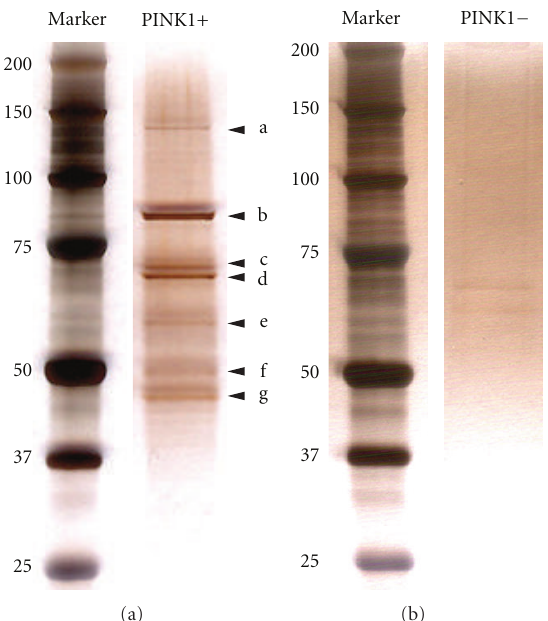
Figure 1: SDS-PAGE result after TAP with overexpressed PINK1. (a) A TAP approach was performed with HEK cells overexpressing PINK1 (PINK1+). Purified proteins were resolved by SDS-PAGE and visualized on the gel by silver staining. Protein bands which were excised from the gel are marked by an arrow head (a–g). (b) In a control experiment, the pull-down approach was performed with beads only (PINK1 − ). A molecular weight marker was used to estimate the size of the detected protein